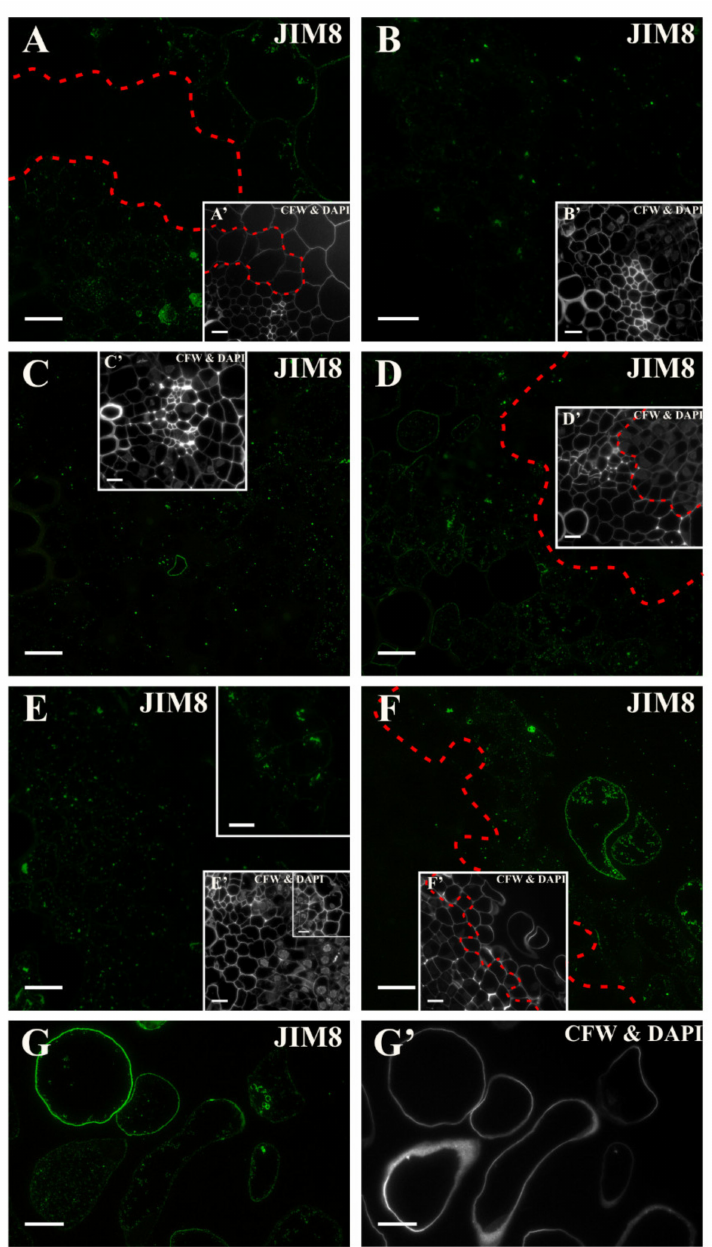
Figure 7. Distribution of the AGP epitope that is recognized by JIM8 antibody at di ff erent time points of the culture. ( A ) A punctate signal was detected in the cell walls of some cells and cytoplasmic compartments of all of the explant cells except for the pericycle cells that were located on the xylem side (area marked with dashed line). ( B , C ) Presence of a punctate signal in the cytoplasmic compartments ( B —3 days, C —4 days of the culture). ( D ) After five days, the occurrence of a signal in the phloem and parenchyma cells was detected. In the dividing cells with a large nucleus (area separated by dashed line), the signal was almost not present. ( E ) After 10 days of the culture, a punctate signal was detected mainly in the parenchyma cells and in the walls and the cytoplasmic compartments of the separated cells (inset). No signal in the cells with meristematic features was found. ( F ) At the end of culture a signal in the cytoplasmic compartments of the cells that are located at the surface of the explant and also in the separated cells was detected (area separated by a dashed line). ( G ) Higher magnification of the separated cells with signal present in the walls and in the cytoplasmic compartments of detached cells. ( A’ – G’ ) Calcofluor white (CFW) and DAPI staining of the section shown on A – G . Scale bars: A – G , A’ – G’ —10 µ